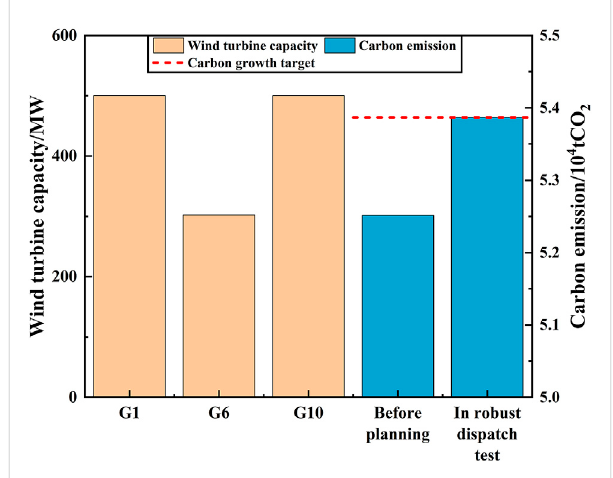
FIGURE 5 The planning results of the proposed model and system carbon emissions.